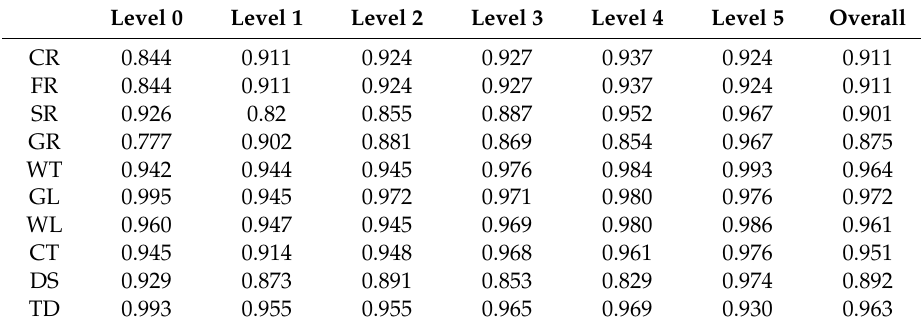
Table 5. Land cover percentage grading accuracy for